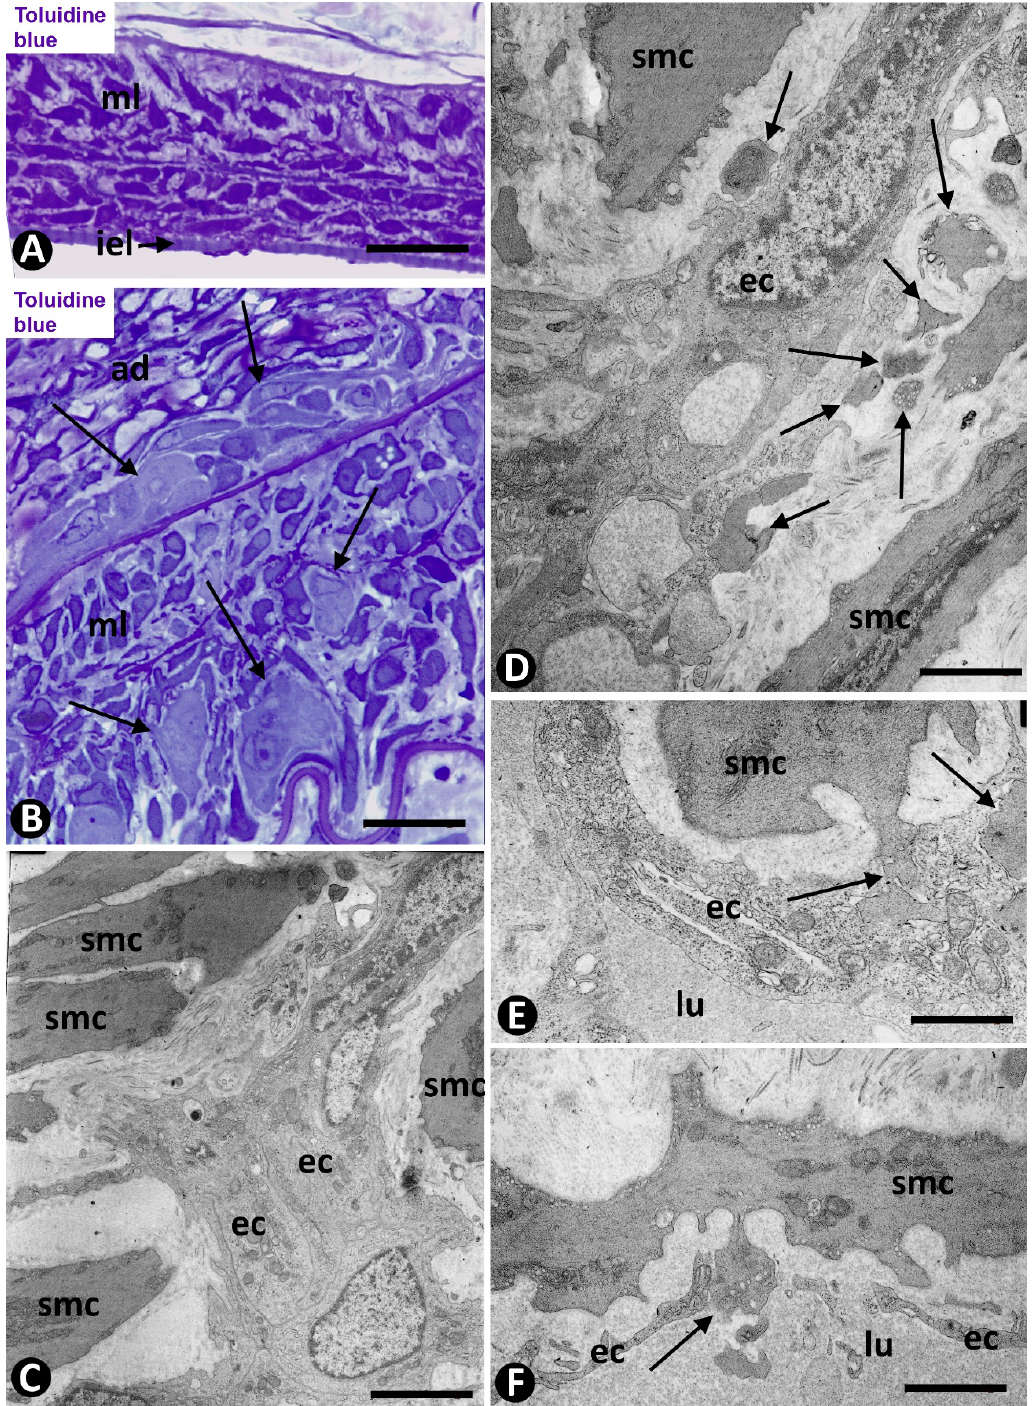
Figure 5. Angiogenesis in experimental occluded arterial segments. ( A ) Arterial segment with loss of endothelium (internal elastic lamina: iel; media layer: ml). ( B ) Capillaries (arrows) in the adventitia (ad) and media layer (ml) of an artery. ( C – F ) ECs (ec) of the capillaries are surrounded by VSMCs (smc) and globular structures (arrows). Note that the globular structures are widened terminal portions of cytoplasmic processes of VSMCs ( E , F ). These bulb-shaped terminal portions establish peg-and-socket-type heterocellular junctions with the ECs ( E ) and they even reach (arrow) the vessel lumen ( F ). Vessel lumen (lu). ( A , B ) Semithin sections stained with Toluidine blue. ( C – F ) Ultrathin sections, uranyl acetate and lead citrate. Bar: ( A ): 25 μ m; ( B ): 10 μ m; ( C , D ): 3 μ m; ( E , F ): 2 μ m.